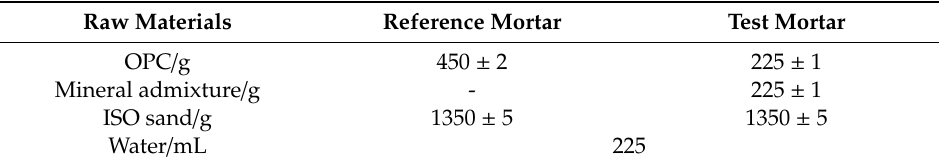
Table 2. Mortar mixes